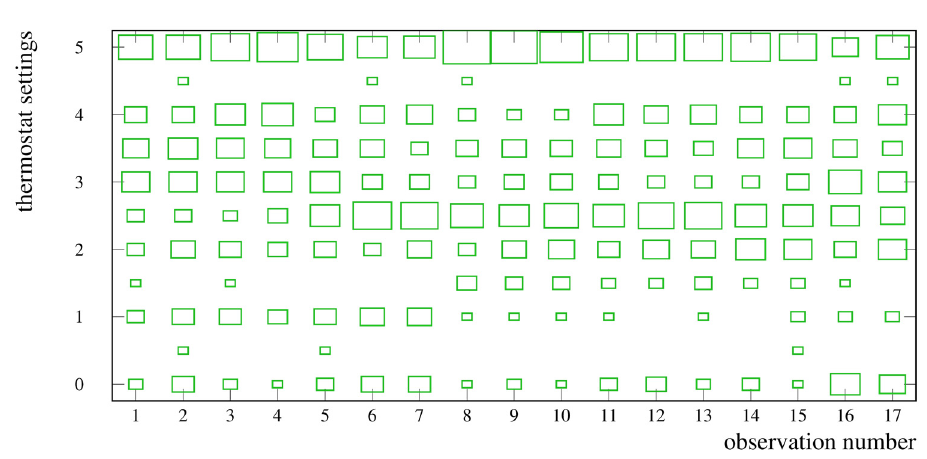
Figure 2. The 2D distribution of thermostat readings in the control group, G1.